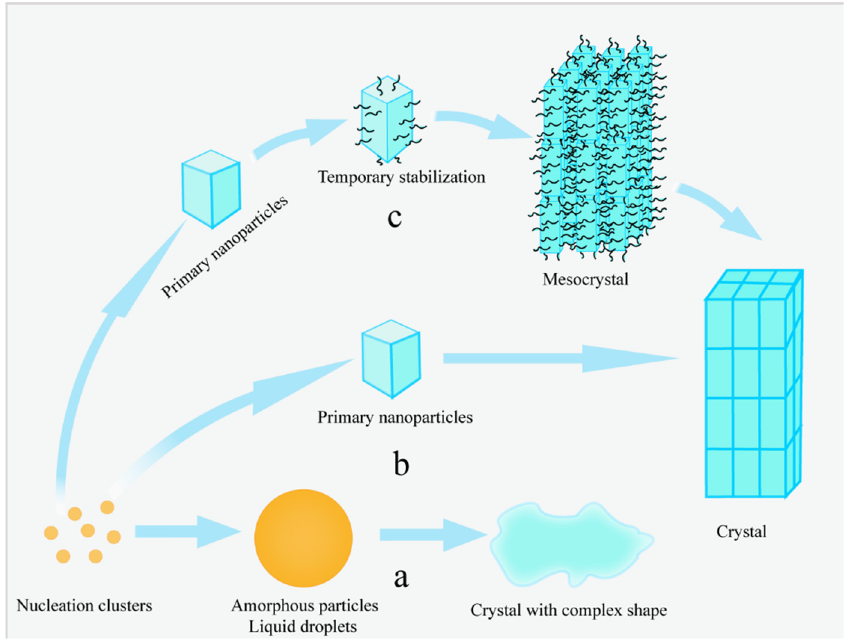
Figure 7. Schematic diagram of ( a ) amorphous precursor growth theory, ( b ) oriented attachment growth theory, ( c ) mesocrystal growth theory.